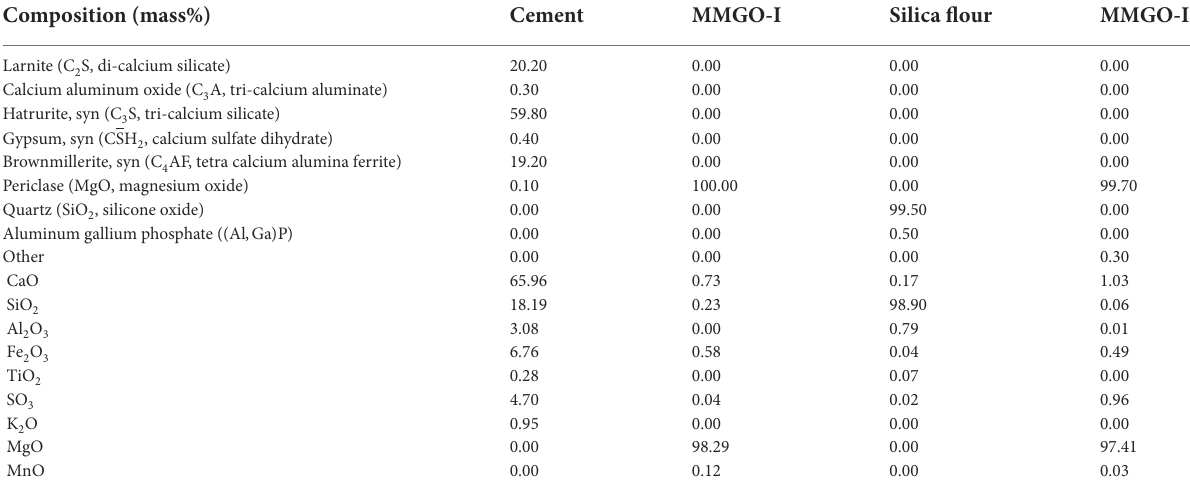
TABLE 1 Chemicalcompositionandoxidescontentsofcement,magnesiumoxides,andsilicaflour(MMI,micro-magnesiumoxide—typeI;MMII, micro-magnesiumoxide—typeII). Composition (mass%)